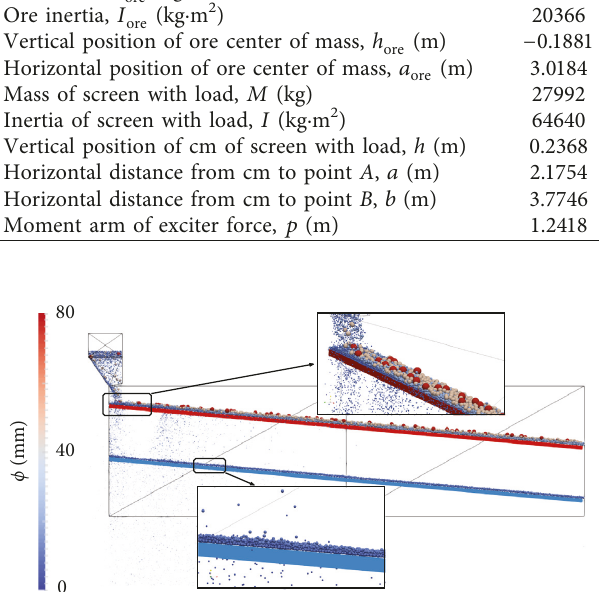
Figure 5: DEM simulation in LIGGGHTS software for a double- deck vibrating screen.